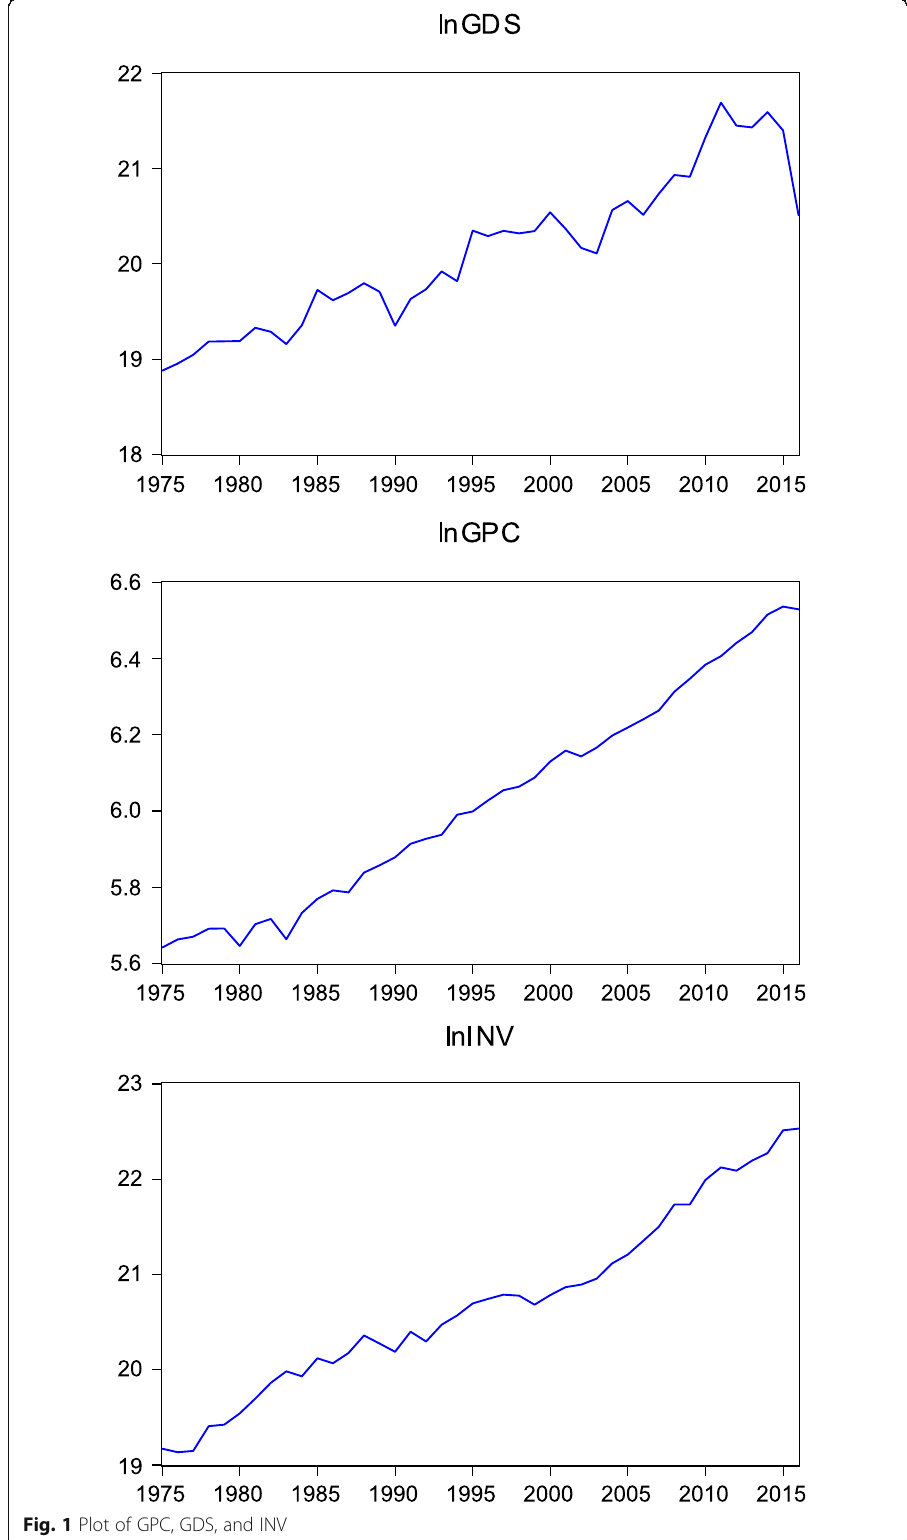
Fig. 1 Plot of GPC, GDS, and